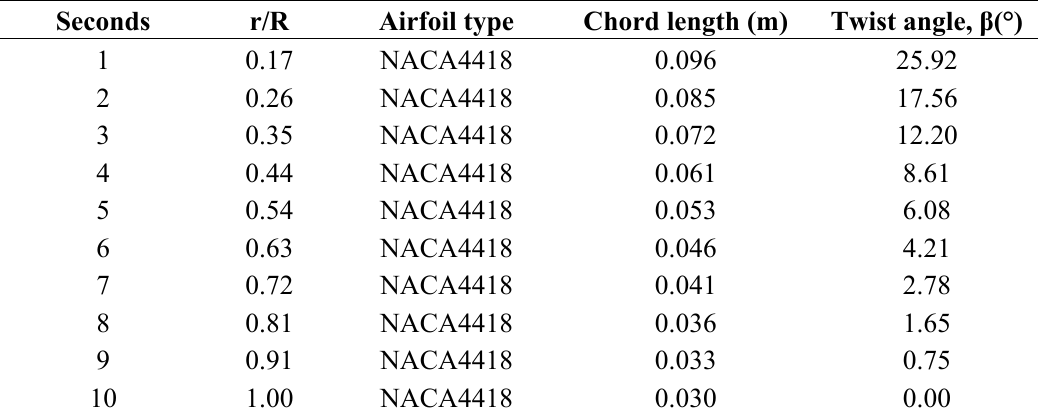
Table 2. Parameters of the OPT blade